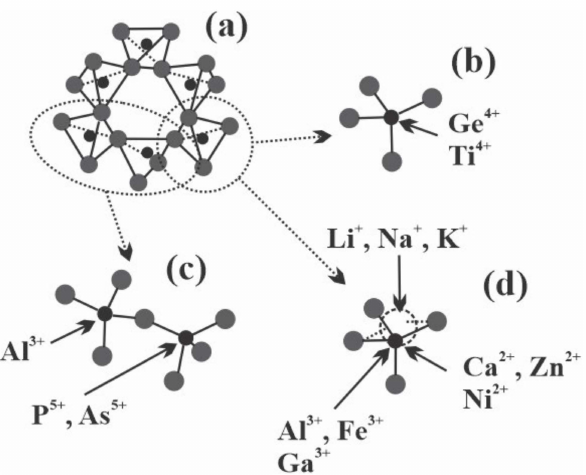
Figure 7. The structural configuration of quartz trace elements. ( a ) Quartz atomic lattice structure. ( b ) Configuration of tetravalent ions (Ge and Ti) as single substitutions for Si. ( c ) Pentavalent ion (P) and trivalent ion (Al) substituted for two Si ions. ( d ) Trivalent ion (Al, Fe, or B) substituted for Si, where charge balance is facilitated by a monovalent ion (Li, Na, or K)